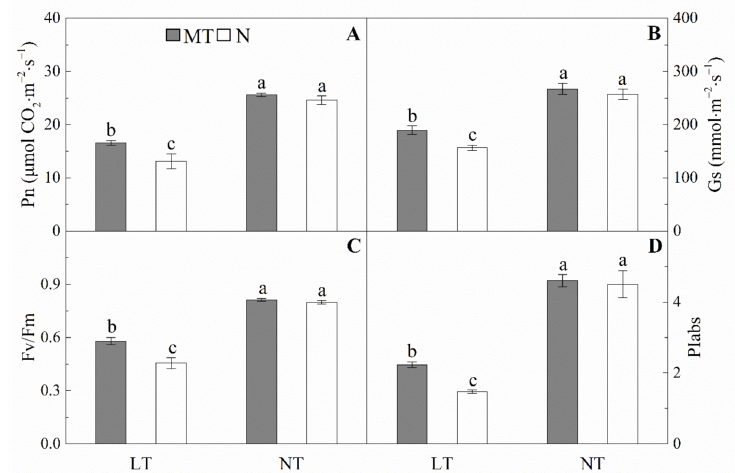
and c) mean significant difference between treatments at p < 0.05 level. ( B ), effects of parental melatonin treatment during